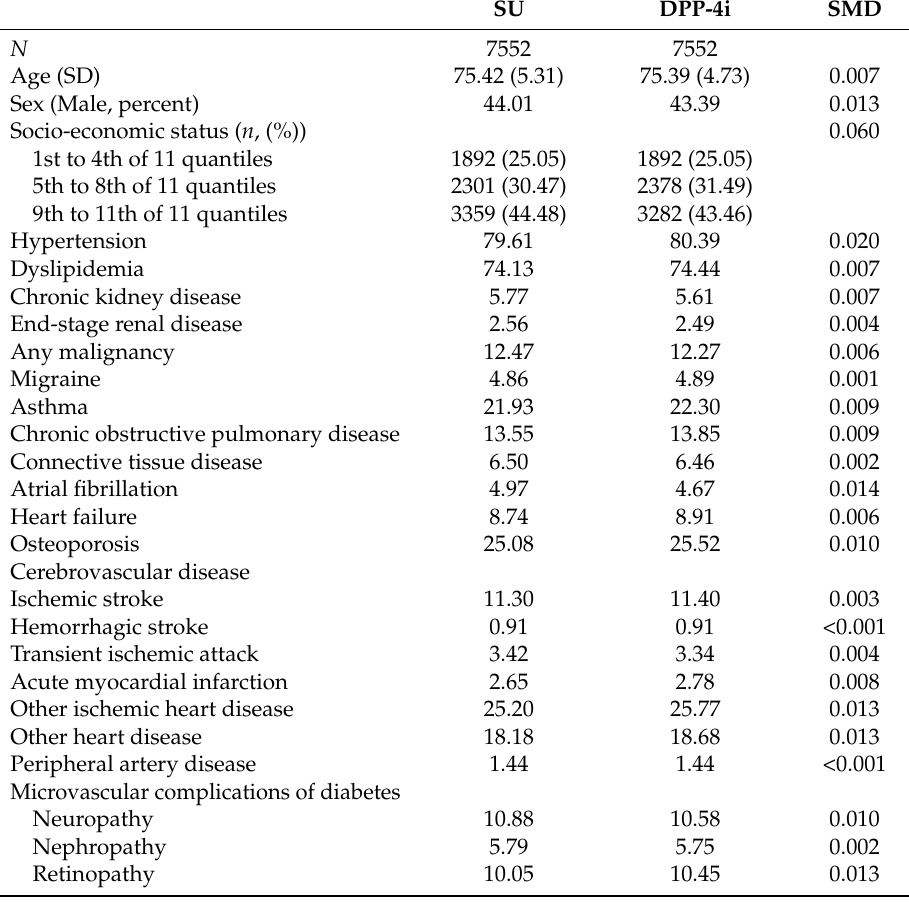
Table 1. Baseline characteristics of the matched